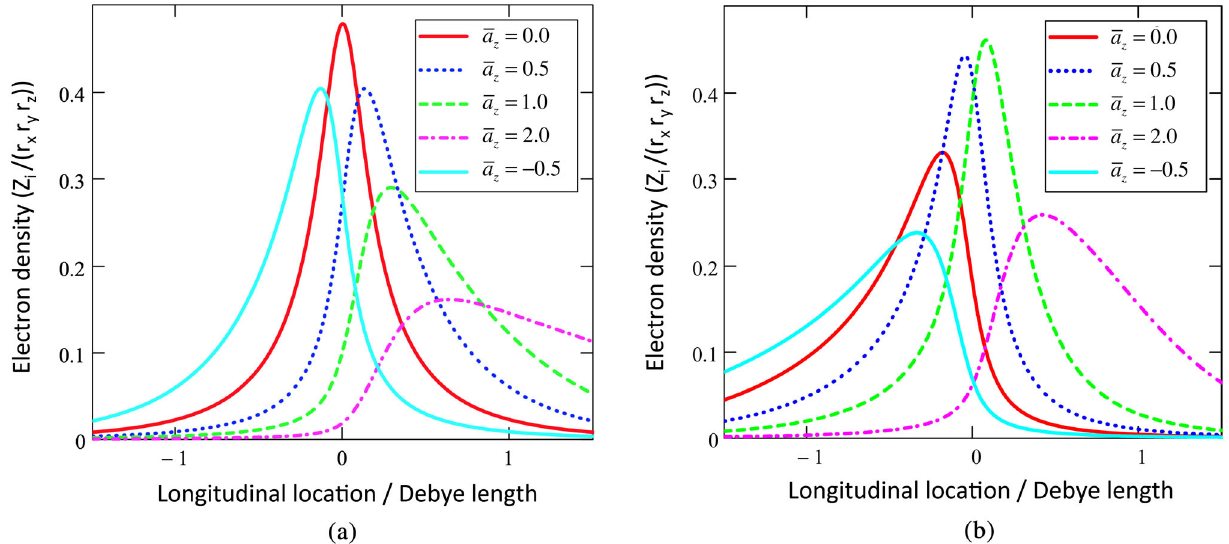
FIG. 1. Profiles of the density modulation induced by an ion in the presence of an external electric field [as calculated in Eq. (11)]. The external electric field is along the z direction and the following values are used for the normalized acceleration: ¯ a (blue), 1 (green), 2 (magenta), and − 0 . 5 (light blue). The abscissa is the longitudinal location in units of longitudinal Debye length, r and the ordinate is the electron density at transverse location x ¼ 0 . 1 r ω t ¼ π = 2 . (a) The ion is at rest; (b) the ion is moving with velocity v 0 p